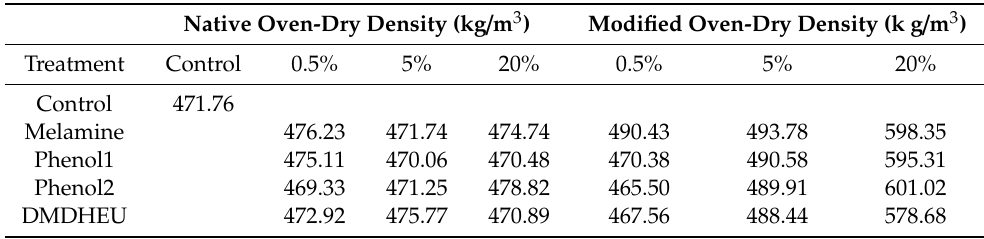
Table 4. Native and modified oven-dry density (g / cm 3 ) of impact bending specimens depending on the modification agent and the concentration (mean).